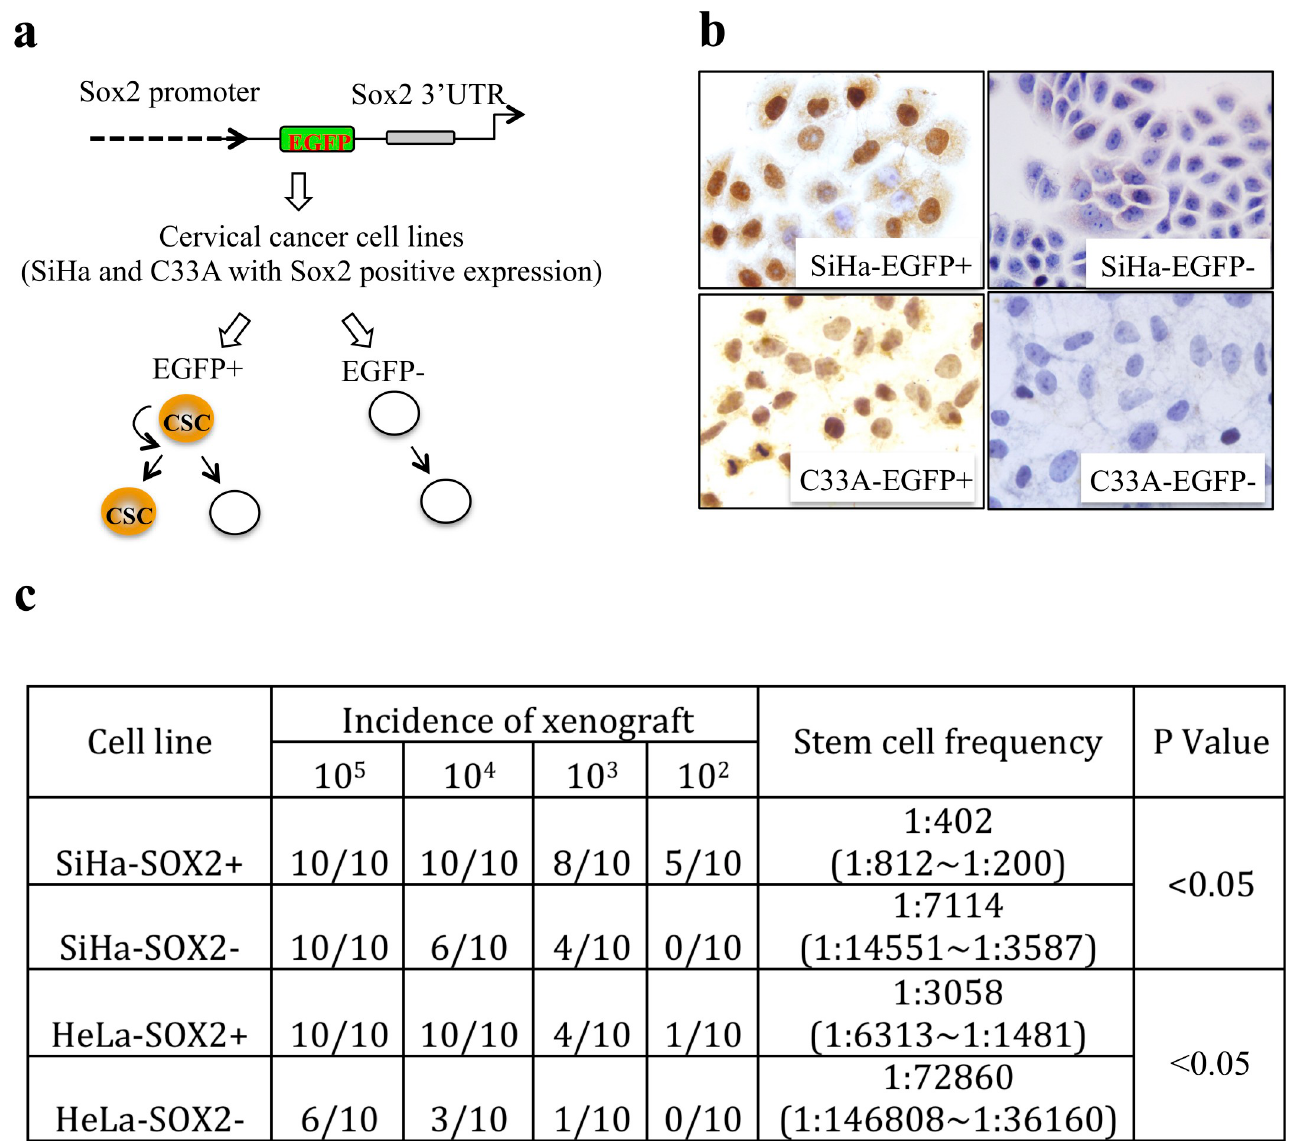
Fig 1. The schematic of SOX2-positive cervical CSCs. (a) The pSox2/EGFP reporter system containing the hSox2 promoter and transcriptional elements including the 3’ UTR, poly (A) tail, and 3’ enhancer were cloned into the pEGFP vector. The pattern of cell proliferation and division was shown in SOX2-positive cervical cancer cells isolated from SiHa and C33A. (b) The expression of SOX2 in EGFP+ and EGFP- cervical cancer cells isolated by pSox2/ EGFP. (c) Sox2+ cells both in SiHa and C33A cells showed heavier tumorigencity and self-renewal in vivo than that in Sox2- cells.